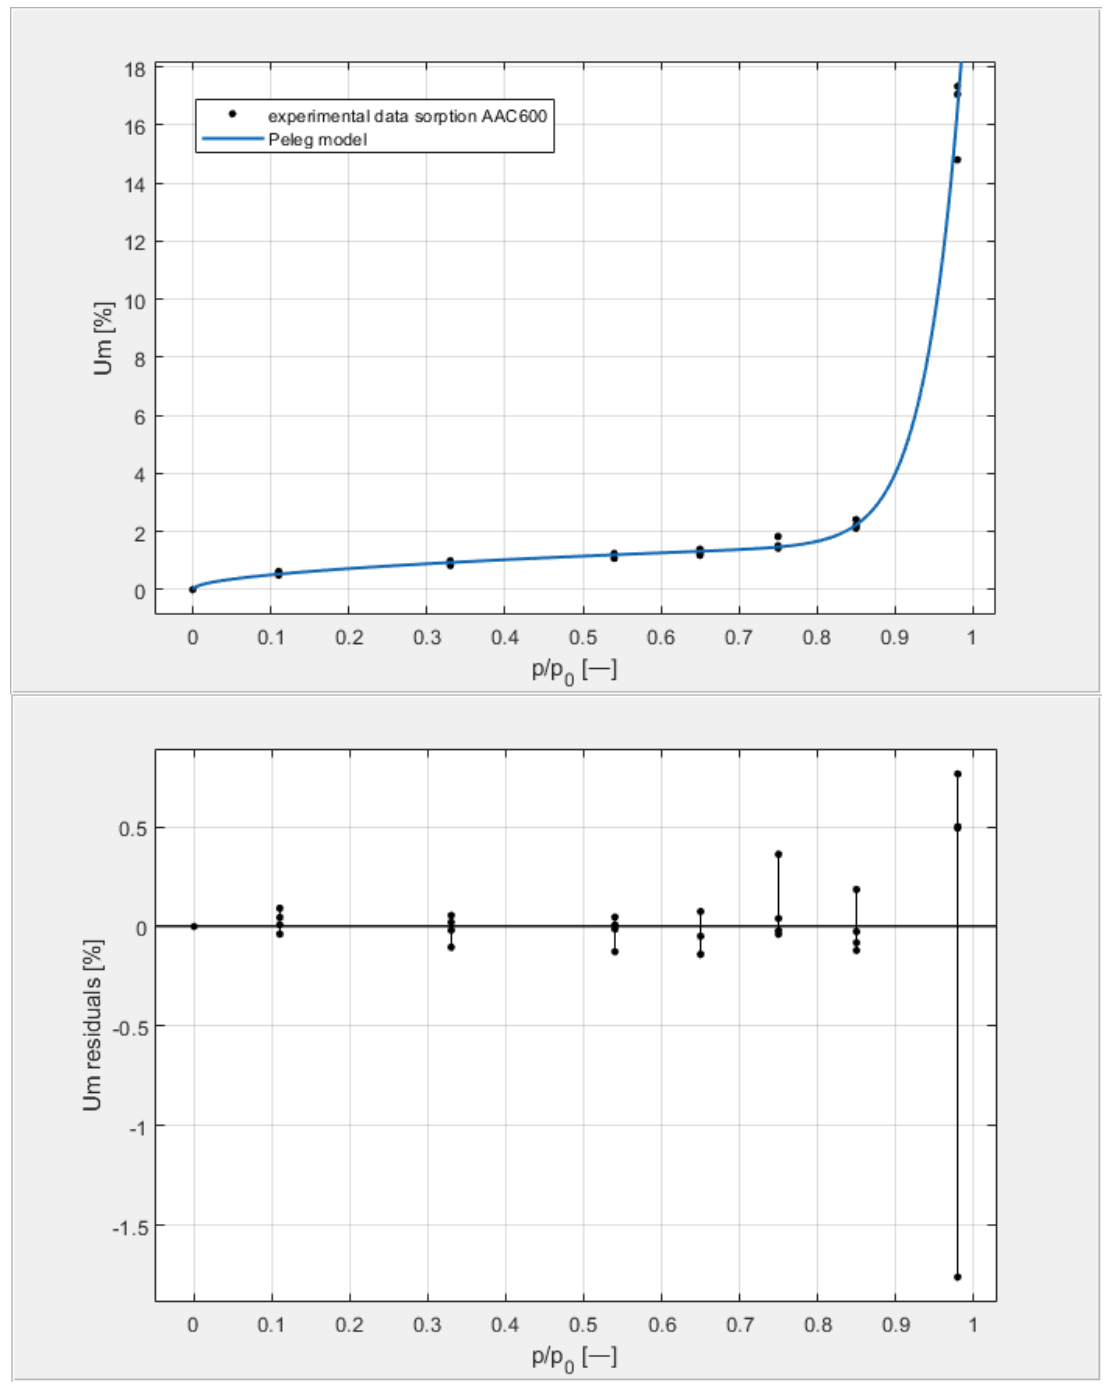
Figure 11. The sorption isotherms of class 600 aerated concrete described by the Peleg equation, plotted with the approximation error.